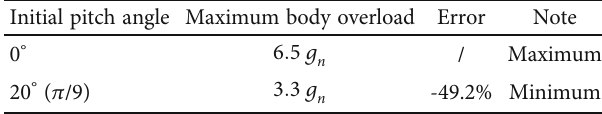
Table 9: Impact of typical working conditions of initial pitch angle on maximum overload of the